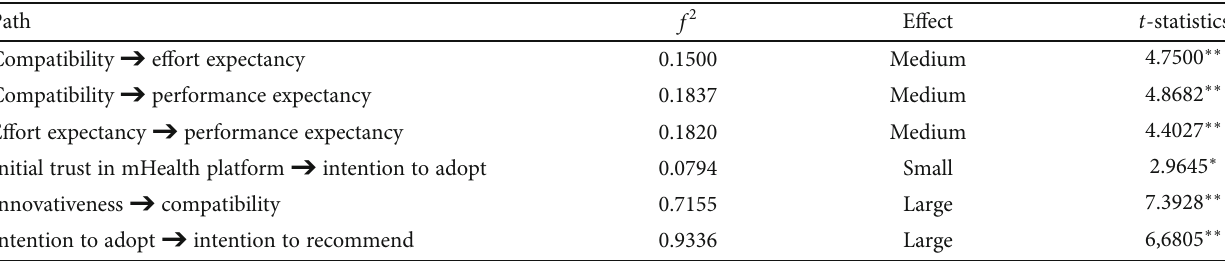
Table 7: Values of f 2 (only values above 0.02 are